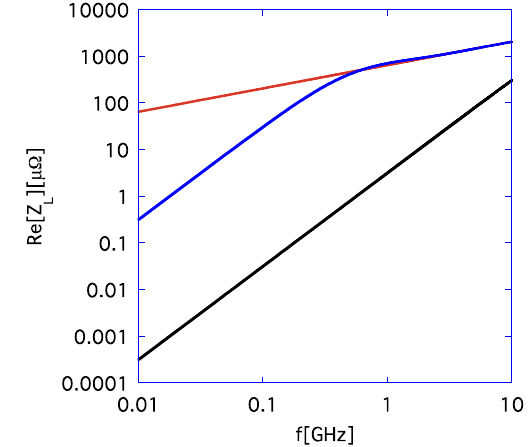
FIG. 3. (Color) The dependence of the real part of the longitu- dinal resistive-wall impedance of a uniform beam pipe (no insert) on the thickness of the chamber. The length of the beam pipe g ¼ 8 mm . Lorentz factor (cid:6) ¼ 1000 . The red, the blue, and the black lines show the cases that the chamber thickness t is equal to infinity, 10 and 1 (cid:13) m , respectively. The impedance for finite thickness starts to deviate from that for infinite thickness at the frequency where the skin depth exceeds the chamber case. The results of t ¼ 1 nm to t ¼ 10 pm in Fig. 4 correspond to this case. The frequency f and the skin D depth (cid:7) are no longer dominant parameters. The new parameter,